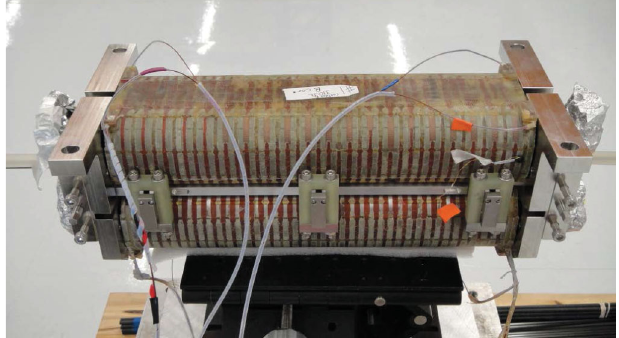
FIG. 4. Photograph of SCU0 magnetic assembly.